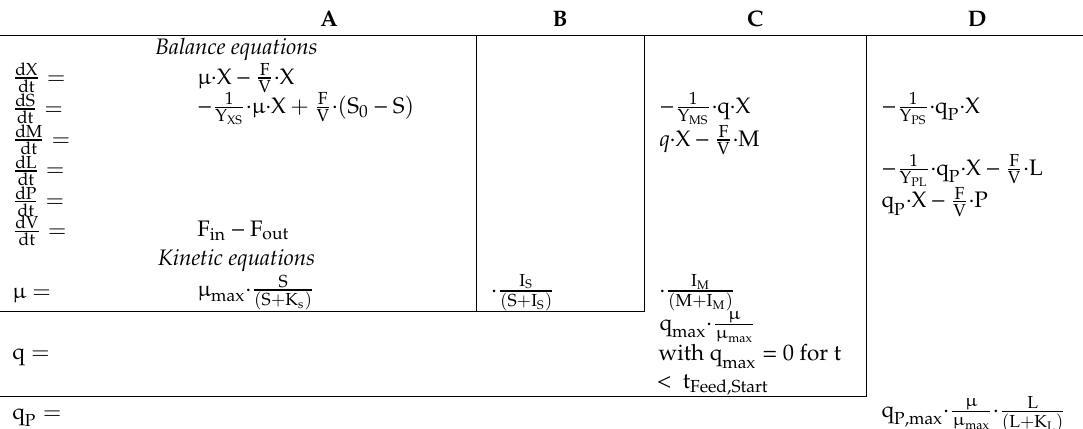
Table 2. Model equations for NMPC. The left side shows the equations for Model A. In the middle-left, the additional inhibition term for Model B is listed, and the middle-right side shows the additional equations for Model C. All equations together form Model D, which also takes the product formation into account. A B C D